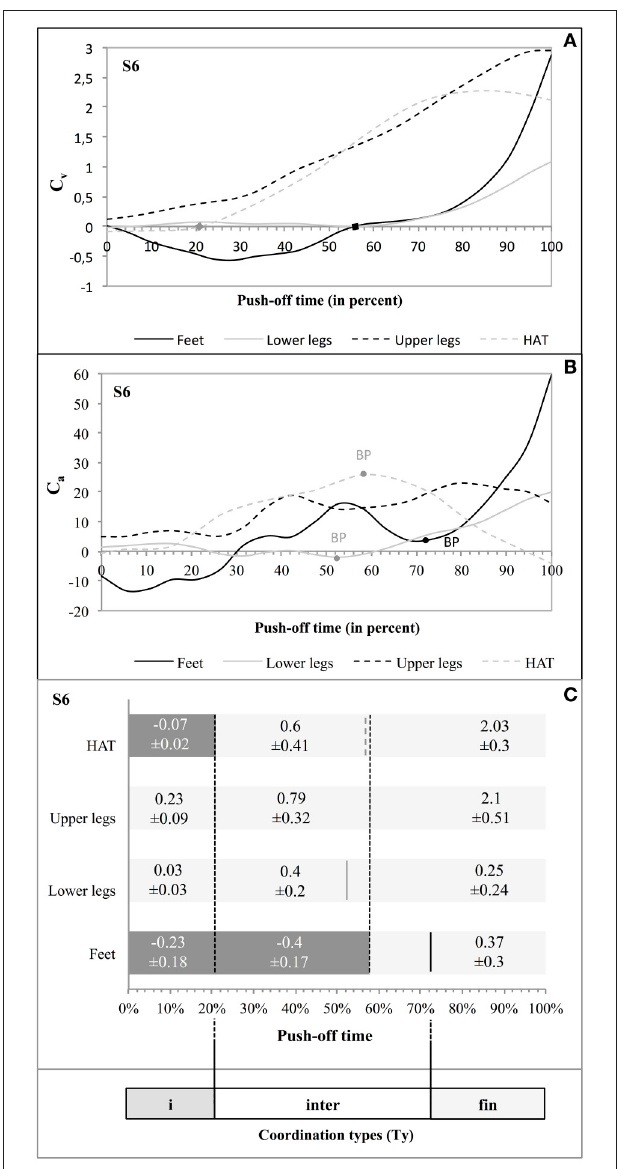
FIGURE 5 | Coordination types (Ty i , Ty inter , and Ty fin ) during push-off in S6. The curves C v as function of time (A) show the influence of each segment of the jumper on the vertical velocity of his MC. The 2 squares on the axis of the abscissa indicate the passage from a negative C v to a positive C v of a given segment on the vertical velocity of MC. The curves C a as function of time (B) show the influence of each segment of the jumper on the vertical acceleration of his MC; the breaking points are given when the p -value gives a significant probability ( p < 0.05 ; see Supplementary Material 4). The bar chart (C) supplies the evolution of C v as function of time for each segment. The mean values of C v ( ± standard deviation) are also given. The doted vertical black lines (crossing the whole bars) indicate the phases of C v for which these values are given. The vertical lines crossing a single bar indicate any breaking point (BP) identified by the Buishand test (full black line = BP feet; full gray line = BP lower legs; and dotted gray line = BP HAT). On this base, three consecutive types of coordination were determined, with: (A) Ty i with 2 negative segmental C v and no BP point in C a ; (B) Ty inter with an evolution in the segmental C v from 1 negative influence to none and 3 BP in C a ; and (C) Ty fin during which each C v was positive, and without any BP in C a .